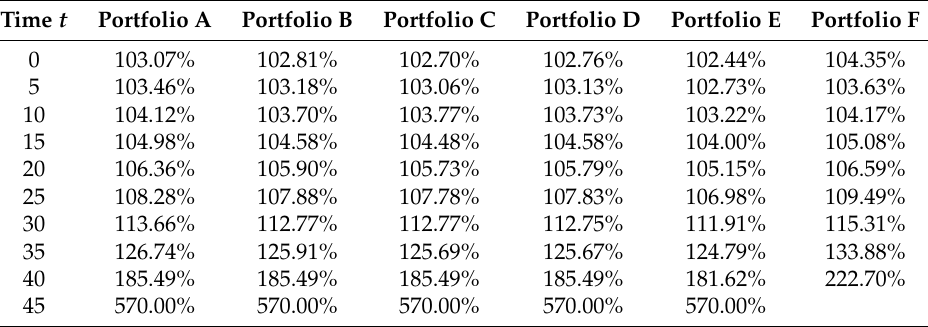
Table 13. Ninety-ninth percentile of PV t , as a % of E [ PV t ]